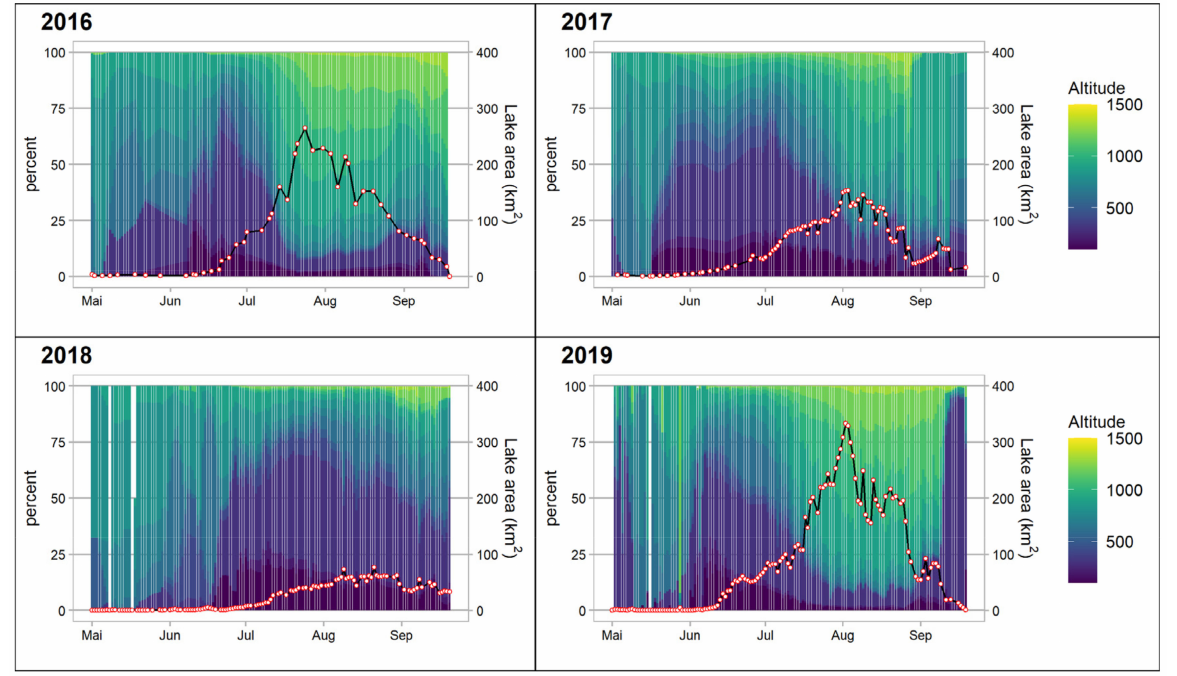
Figure 6. Lake area by elevation bins of 100 m as a percent of the total lake area per date between 1 May and 20 September (colored slices). Red dots show total lake area in km 2 . Values between observations (red dots) interpolated using linear